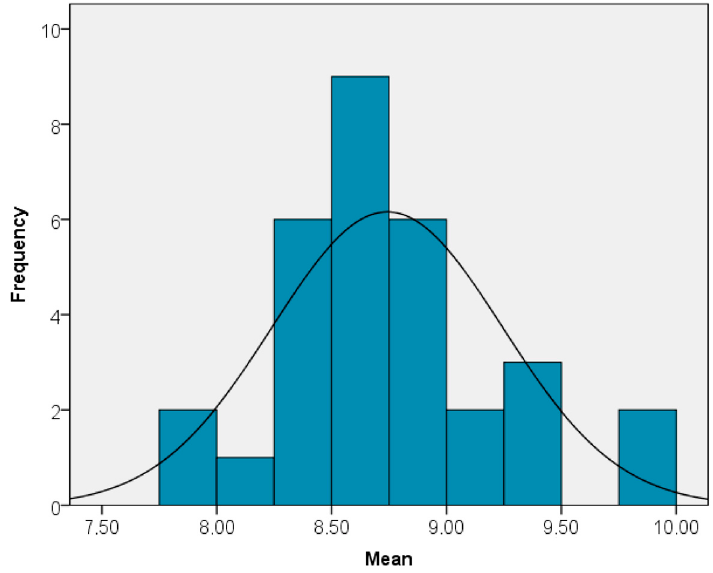
Figure 5. Histogram of the mean study scores of the pilots (source: created by the authors).